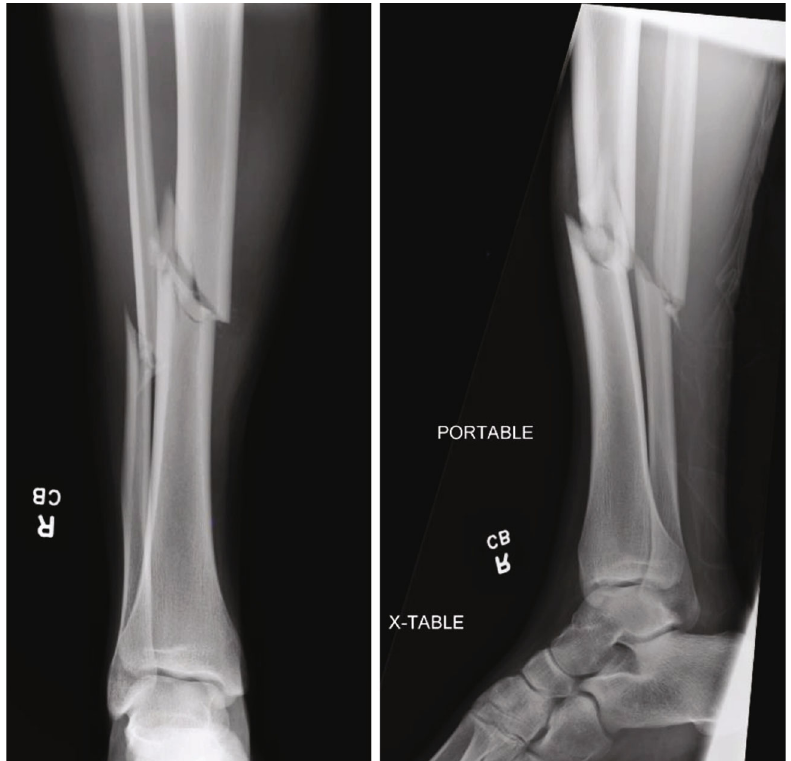
Figure 1: Injury radiographs. AP and lateral radiographs of the right tibia and fi bula obtained at an outside hospital emergency department demonstrated a short oblique diaphyseal tibia fracture with mild comminution.